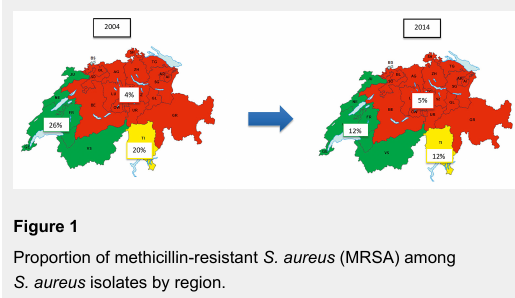
Proportion of methicillin-resistant S. aureus (MRSA) among S. aureus isolates by region. Red = German-speaking; green = French-speaking; yellow = Italian-speaking